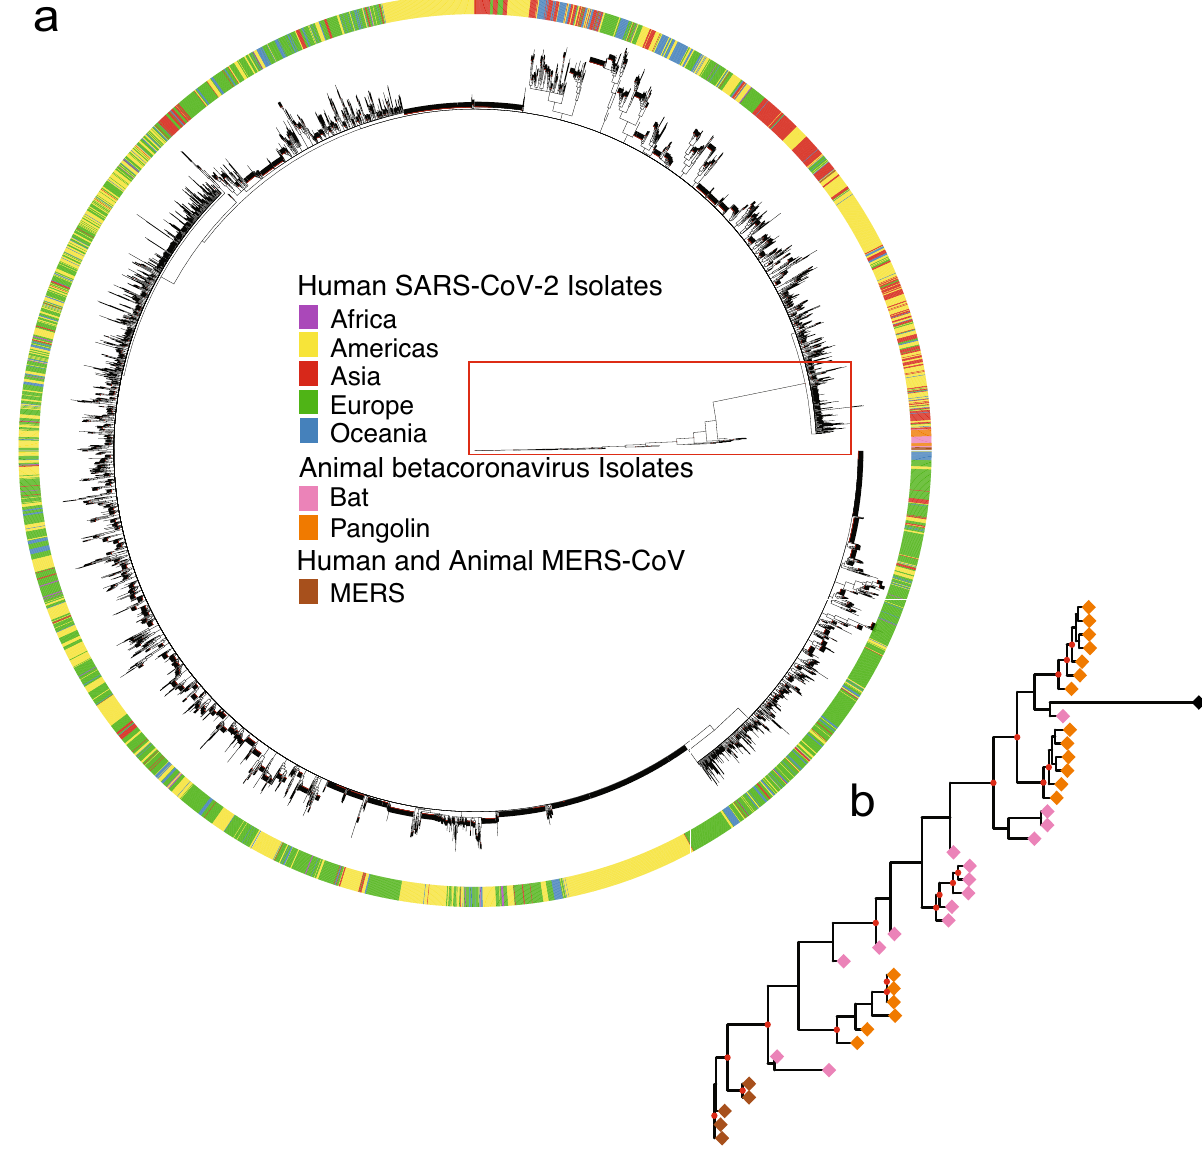
Figure 2. Consensus species tree of human, bat, and pangolin coronaviruses resolves the different histories of 11 gene trees in the coronavirus genome and was constructed by two methods (see Materials and Methods) from 5,248 viral genomes. ( a ) Using a distance based neighbor-joining method (Materials and Methods), the 5000 + taxa are represented in a circular consensus species tree. The outer circle designates regions. Each of the regions (Africa, Americas, Asia, Europe, and Oceania) in the consensus species tree have 80% of their viral genomes identified from that region or 80% bootstrap support and at least 50 viral genomes. ( b ) A blowup of the pangolin and bat coronavirus clades. Red dots indicate bootstrap support of at least